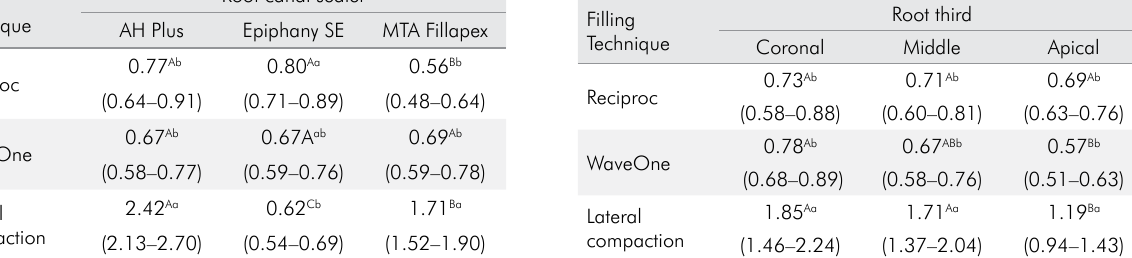
MPa: megapascal. Distinct letters (uppercase for line, lowercase for row) indicate significant differences (p < 0.05).